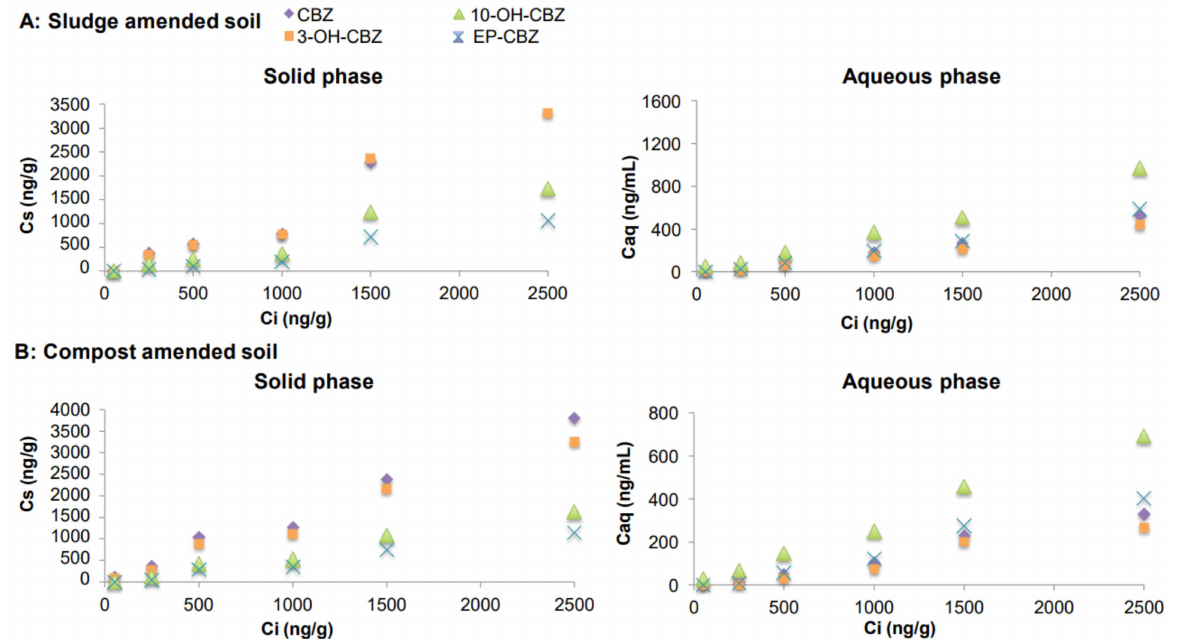
Figure 1. Concentrations of CBZ and its metabolites in soil samples amended with spiked sewage sludge ( A ) and compost ( B